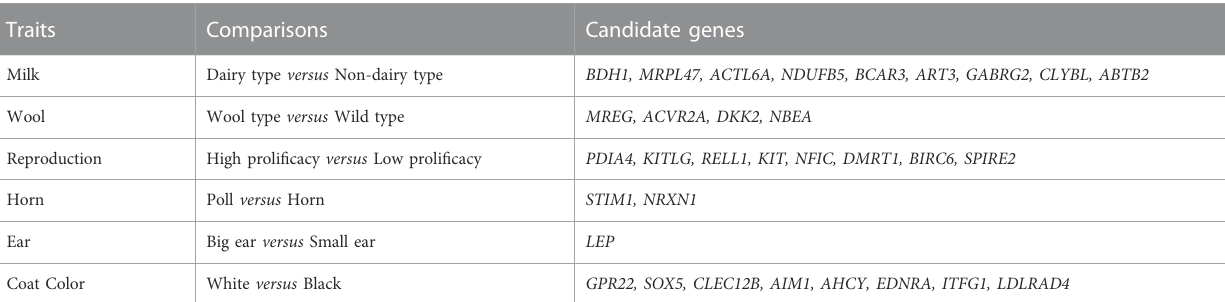
TABLE 2 Candidate genes under selection based on pairwise F ST and θ π ratio